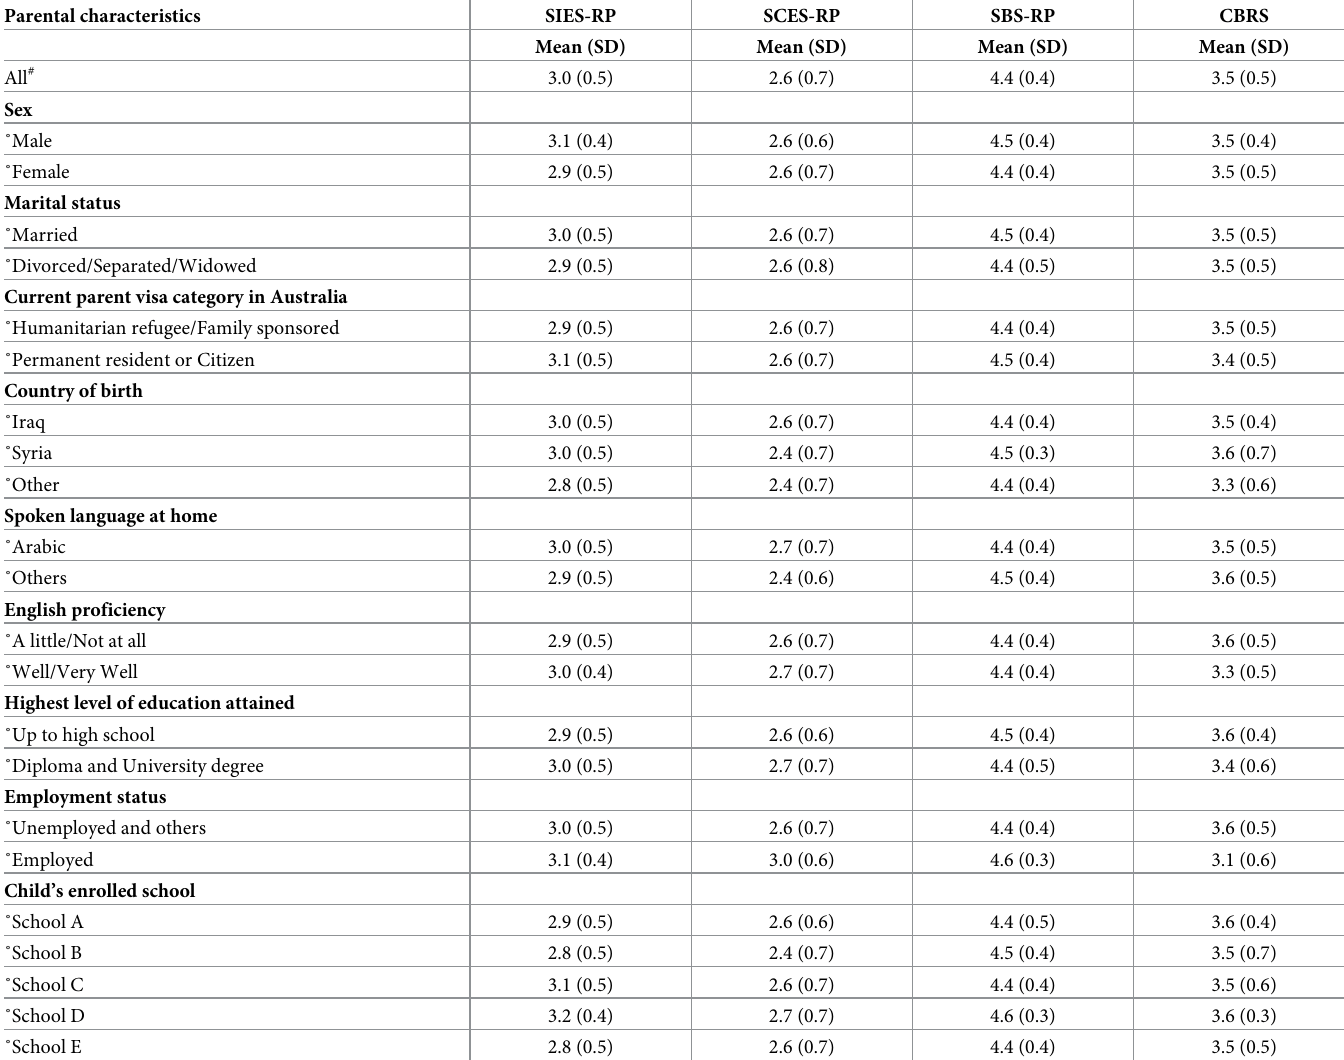
Table 5. Mean of the school measures by parent